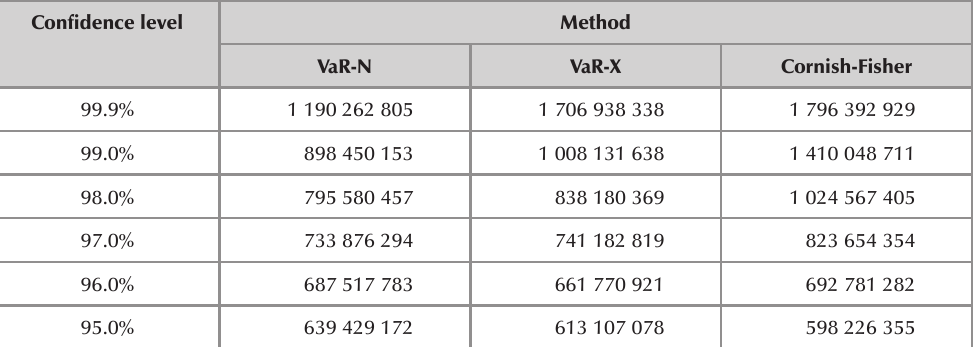
Comparison of VaR-N and VaR-X values with the Cornish-Fisher-Expansion for a linear 10 000 contract position in the Top